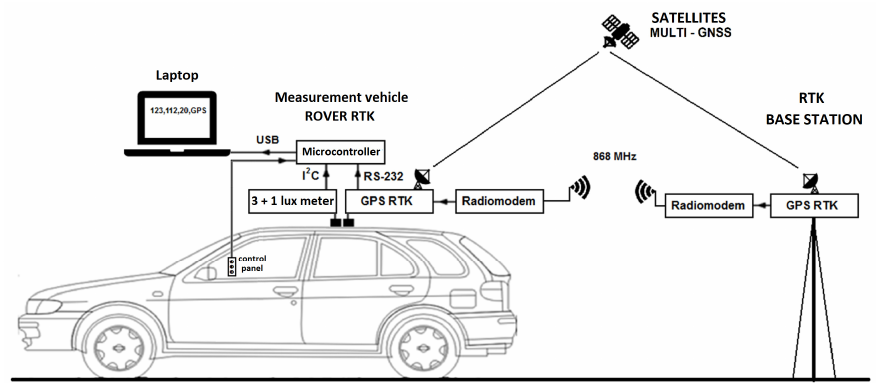
Figure 1. Schematic diagram of a mobile measurement system using GPS RTK. Digital illuminance sensors OPT3001 (Figure 2) from Texas Instruments [63], with a spectral sensitivity V( λ ) similar to that of human eyes (Figure 3) and a measurement frequency of 5 Hz, were used to build the designed